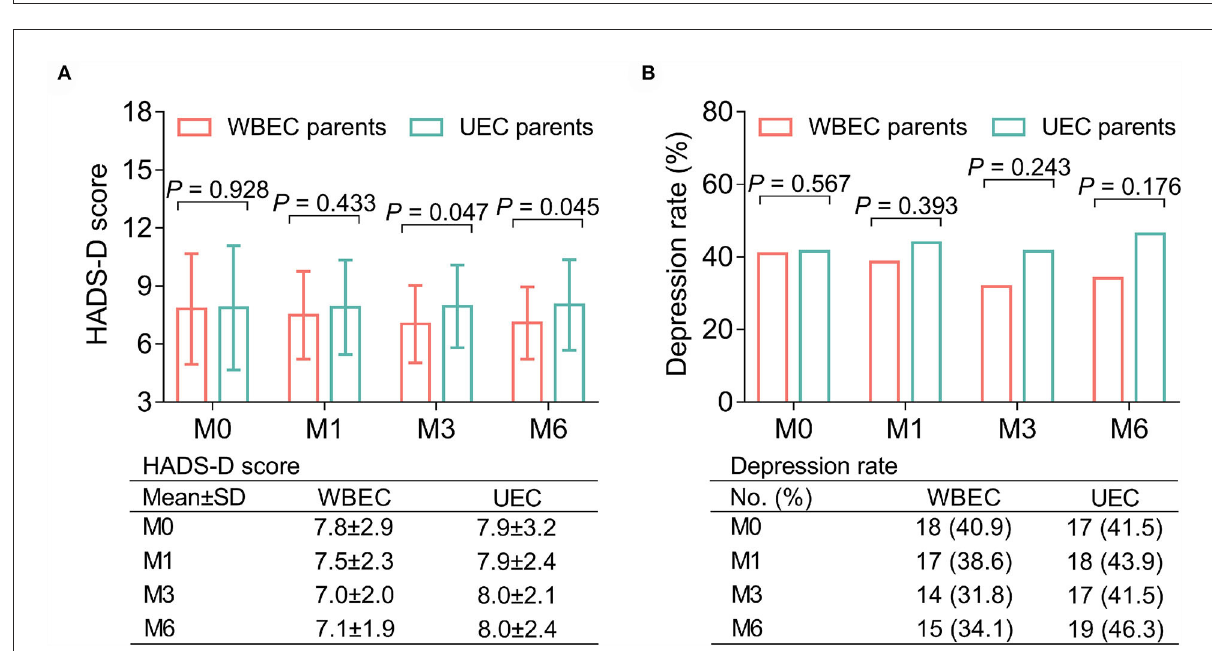
FIGURE3 Effect of WBEC on depression in parents of pediatric and adolescent patients with osteosarcoma. Comparison of HADS-D score (A) and depression rate (B) between parents in WBEC group and UEC group at M0, M1, M3, and M6. WBEC, WeChat-platform-based education and care program; UEC, usual education and care program; HADS-D, Hospital Anxiety and Depression Scale for depression; M, month.